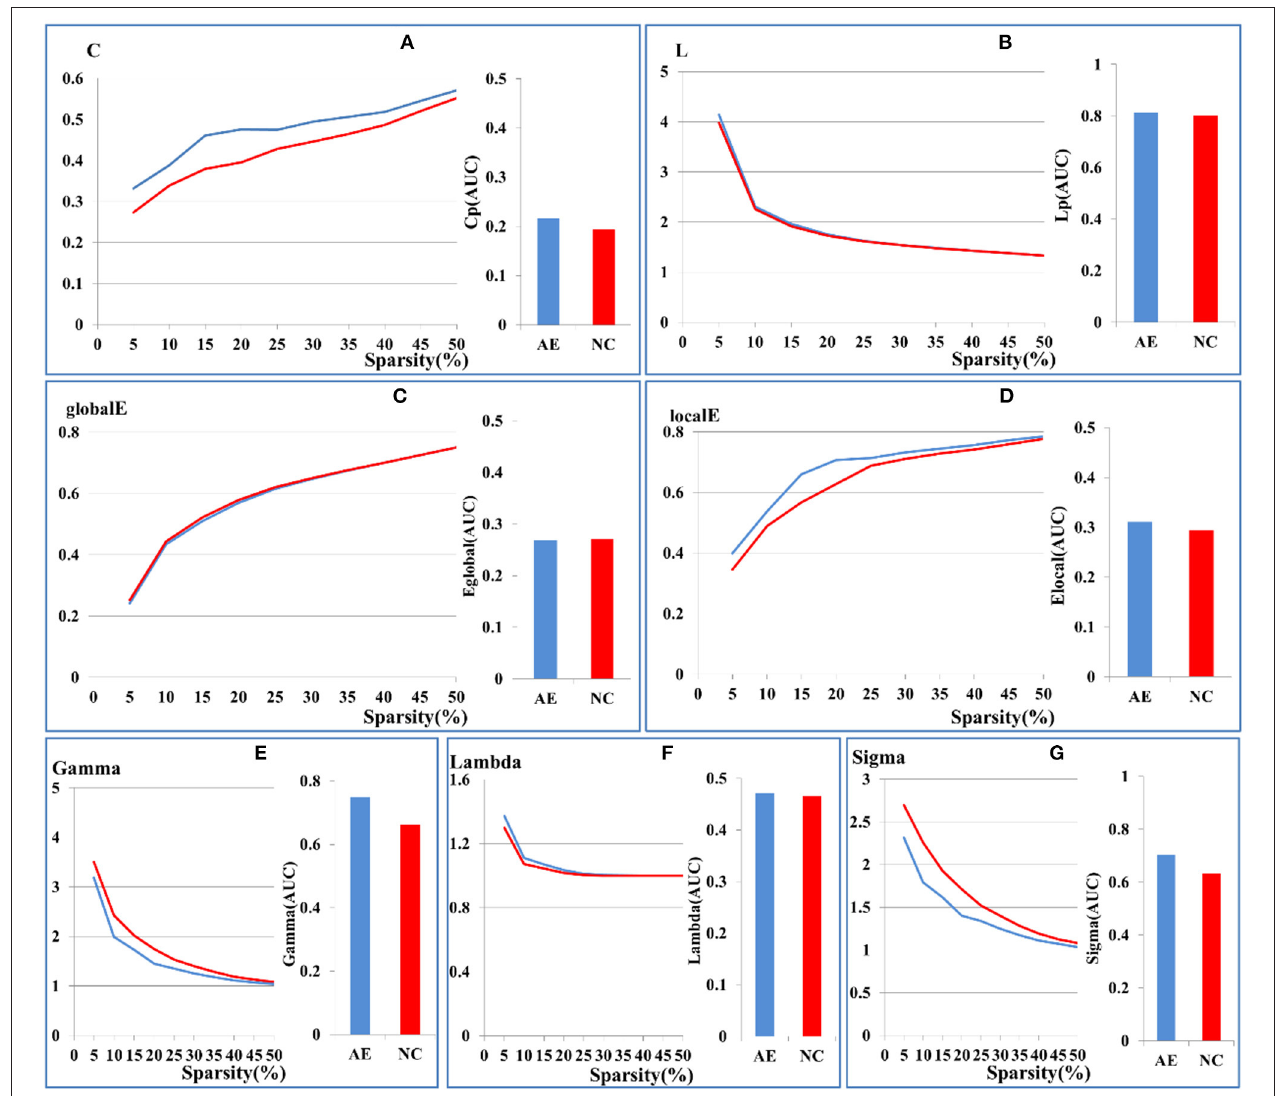
FIGURE 1 | Comparison of global brain network parameters between patients with anti-NMDAR encephalitis and health controls. (A) clustering coefficient, (B) shortest characteristic path length, (C) global network efficiency, (D) local network efficiency. Sigma values of the two groups in the range of 5–50% sparsity was calculated by Gamma (E) , Lambda (F) , Sigma (G) . The X-axis coordinates represent sparsity thresholds ranging from 5% to 50%. Results from patients with anti-NMDAR encephalitis are in blue, and those from healthy controls are in red. The bar chart shows the AUC values of the two